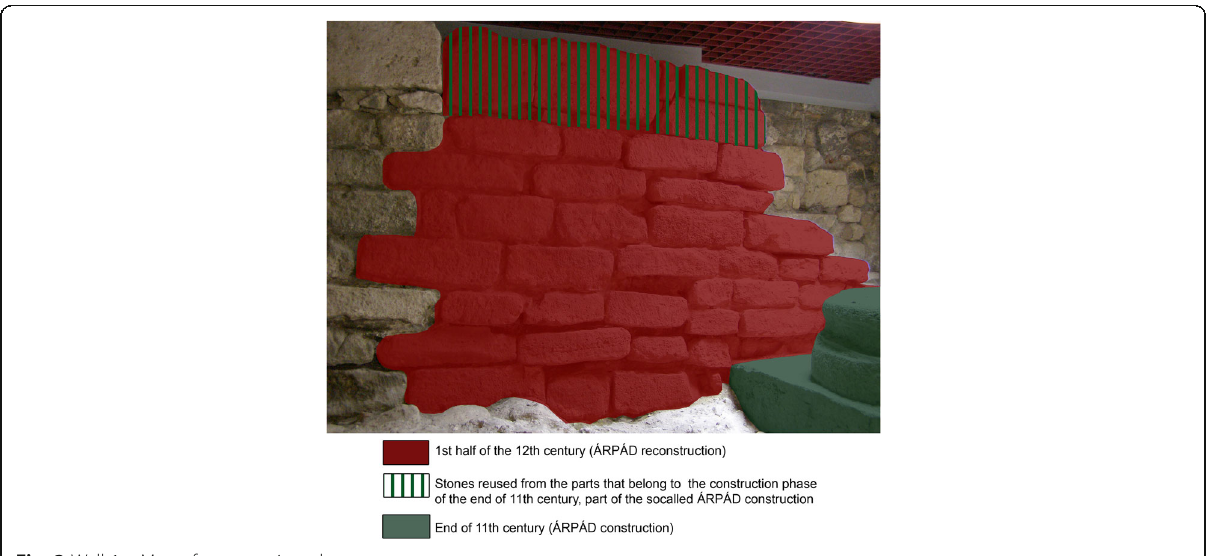
Fig. 3 Wall 1 — Map of construction